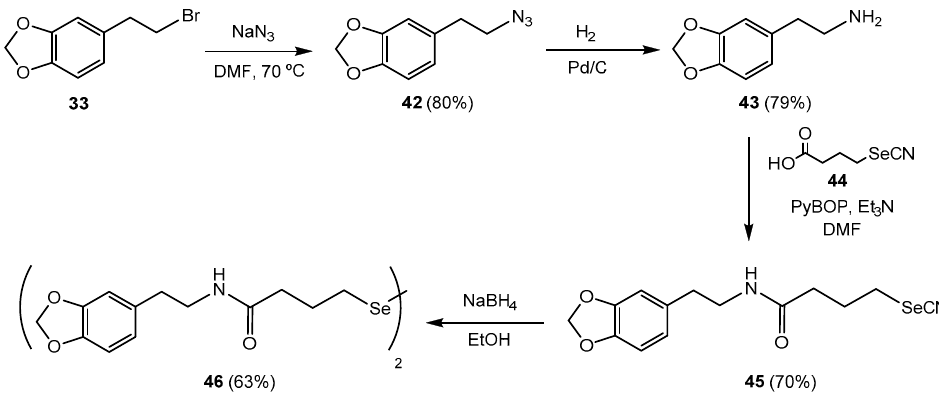
Scheme 5. Preparation of O -protected phenolic-based selenides, selenocyanates and diselenides.